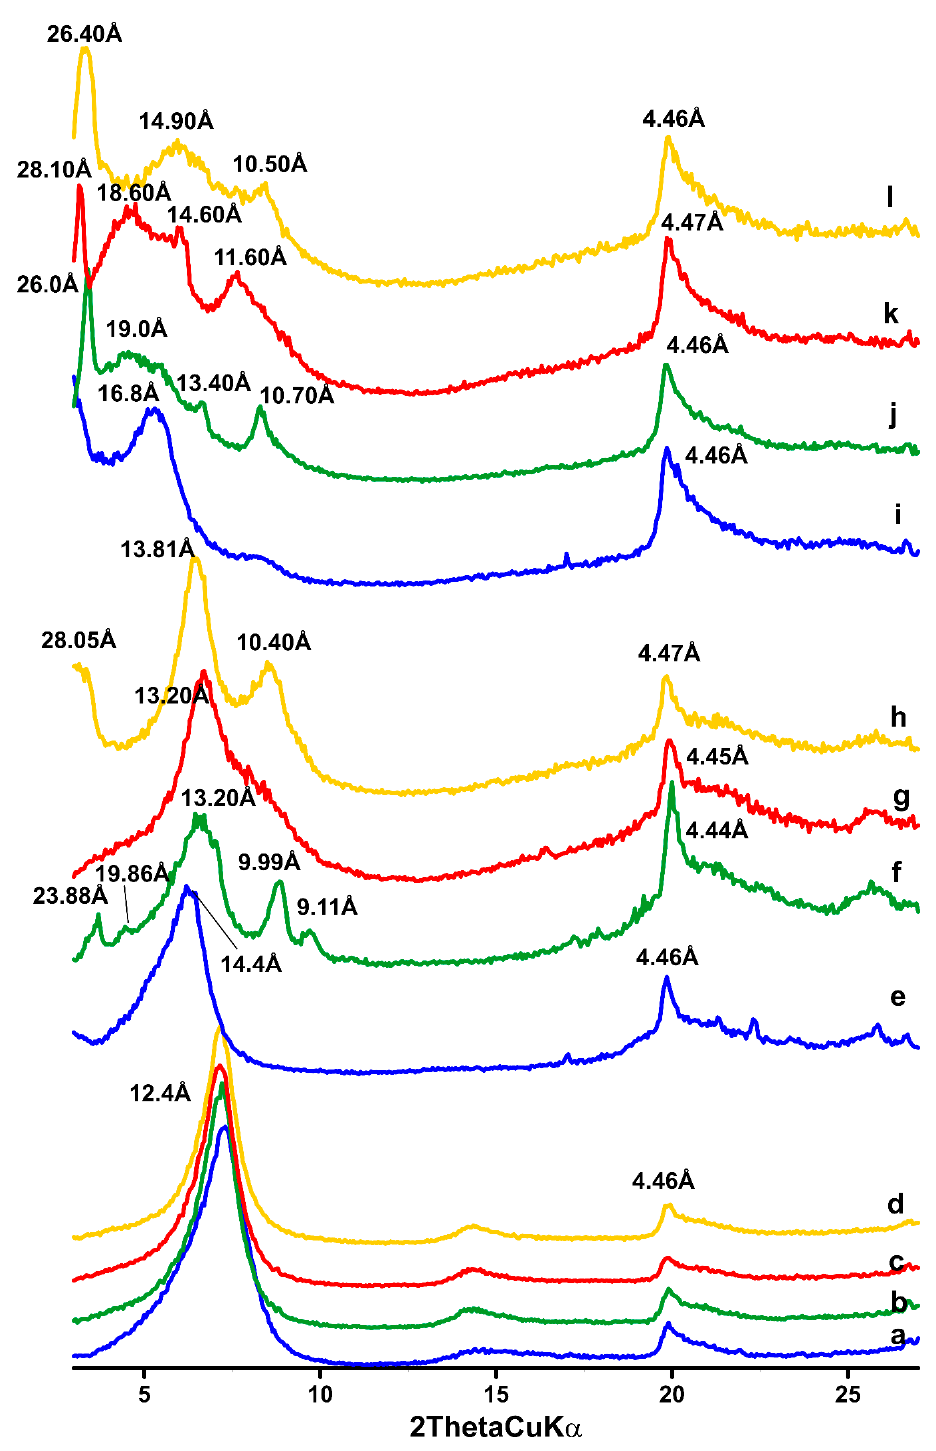
Figure1. XRDpatternsofsamples: ( a )Na-M,( b )Na-M-Mo, ( c )Na-M-W,( d )Na-M-MoW,( e )DDTMA-M, Figure 1. XRD patterns of samples: (a) Na-M, (b) Na-M-Mo, (c) Na-M-W, (d) Na-M-MoW, (e) ( f ) DDTMA-M-Mo, ( g ) DDTMA-M-W, ( h ) DDTMA-M-MoW, ( i ) DDDDMA-M, ( j ) DDDDMA-M-Mo, DDTMA-M, (f) DDTMA-M-Mo, (g) DDTMA-M-W, (h) DDTMA-M-MoW, (i) DDDDMA-M, (j) ( k ) DDDDMA-M-W, ( l ) DDDDMA-M-Mo, (k) DDDDMA-M-W, (l) DDDDMA-M-MoW.